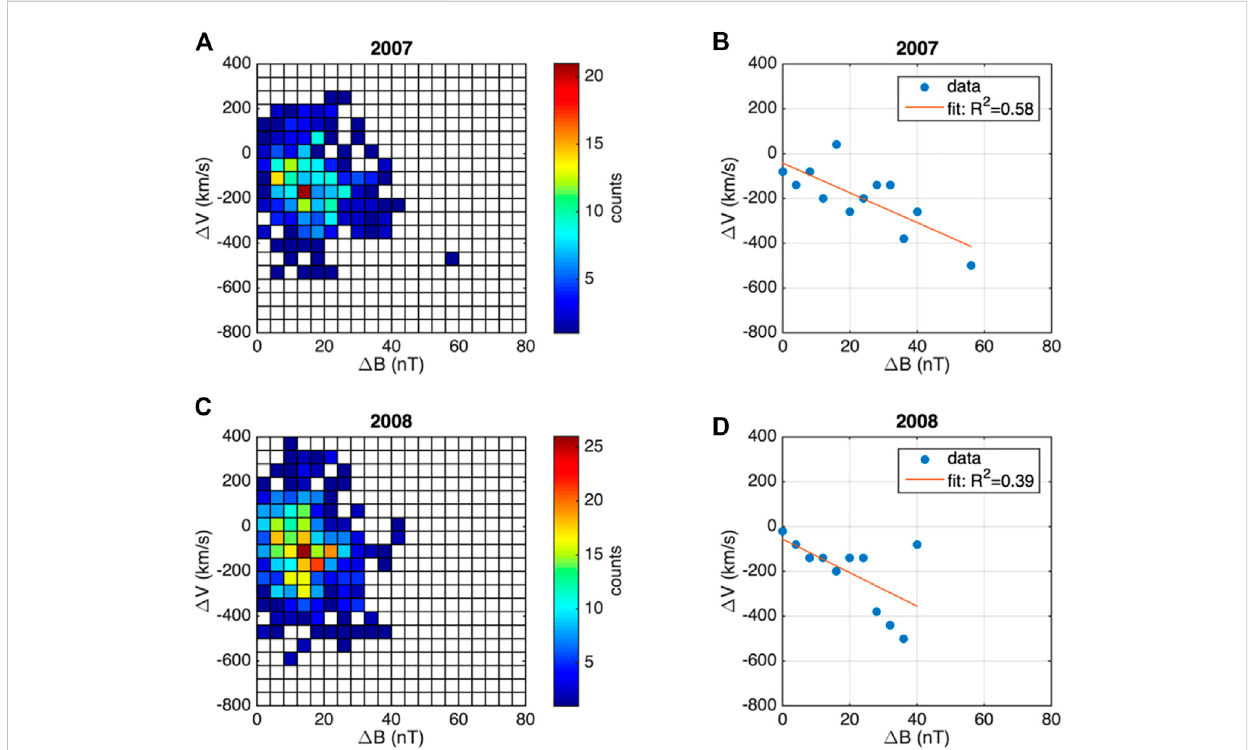
FIGURE 13 Left column: 2D histograms in the space de fi ned by the jet perpendicular velocity breaking, quanti fi ed by the difference between the perpendicular jet speed at maximum dynamic pressure and the solar wind perpendicular speed, and total magnetic variation, Δ B , estimated as the difference between the jet magnetic fi eld and the solar wind magnetic fi eld, for 2007 (A) and 2008 (C) . Right column: Linear fi t of Δ V function of Δ B , where Δ V is computed fromtheaverageoverallbinsin Δ V correspondingtoeach Δ B valueinthe2Dhistogramatleftfor2007 (B) and2008 (D) .Theresultsareobtainedfor a subset of jets in the subsolar magnetosheath | Y GSE | < 5 R E